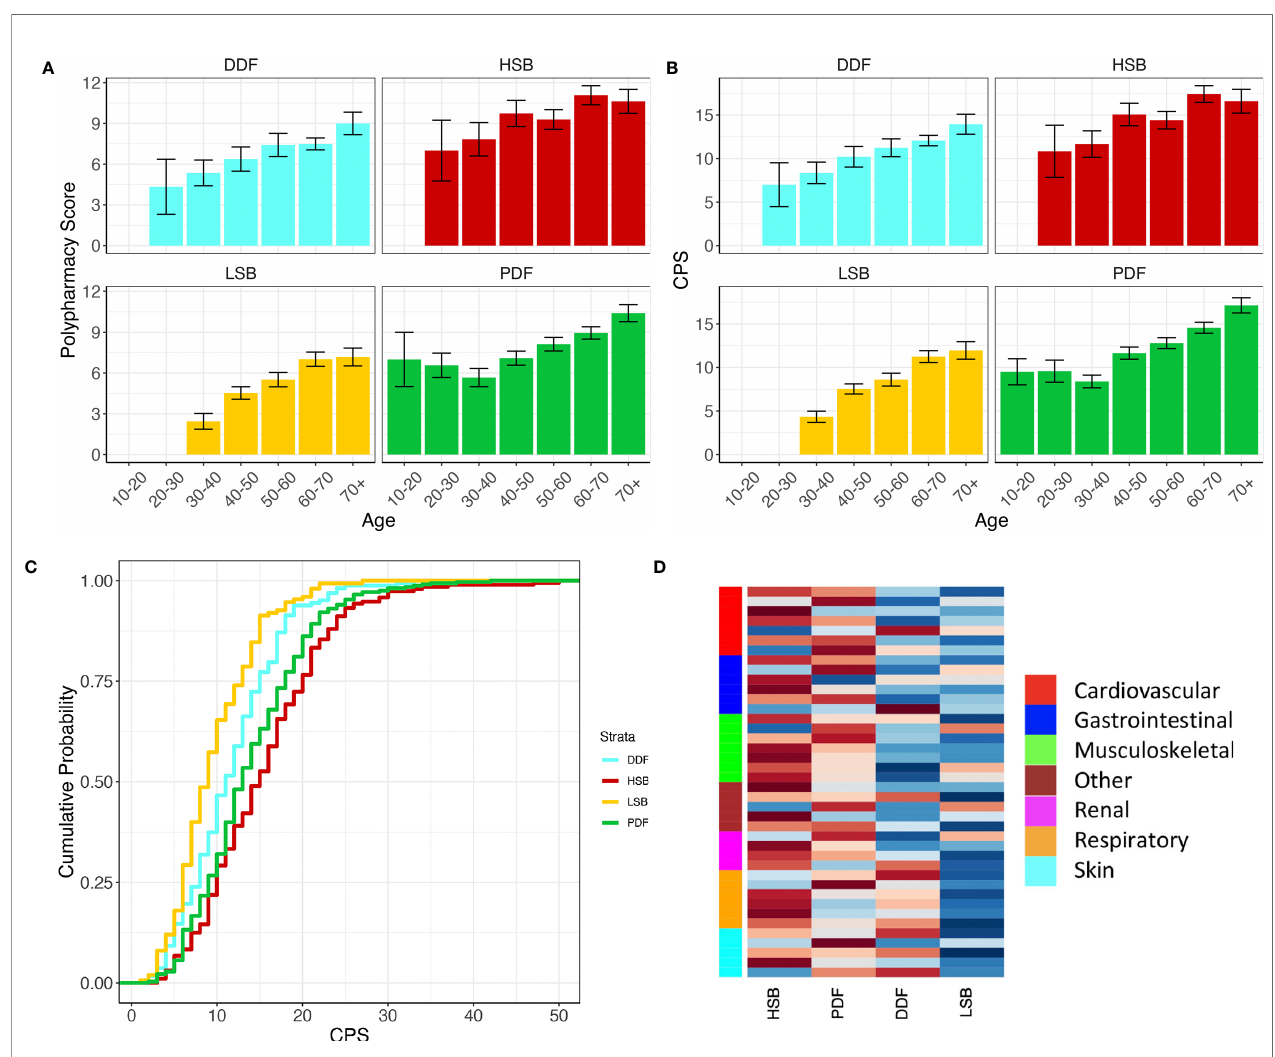
FIGURE 1 | Polypharmacy score (A) and CPS score (B) increase with age in all symptom burden subgroups. Cumulative distribution plot showing higher CPS in the HSB and PDF groups compared to the LSB and DDF groups (C) . (D) Heatplot of the proportions of the top 40 comorbidities (ICD10) in the four subgroups. The heatplot cells are scaled row-wise where colour scale is representative of the proportions of each comorbidity separately across the four subgroups. A darker red colour represents a higher proportion and darker blue colour represents a lower proportion. Side bar colours denote a representative category for each comorbidity. For full annotation see Supplementary Figure S1